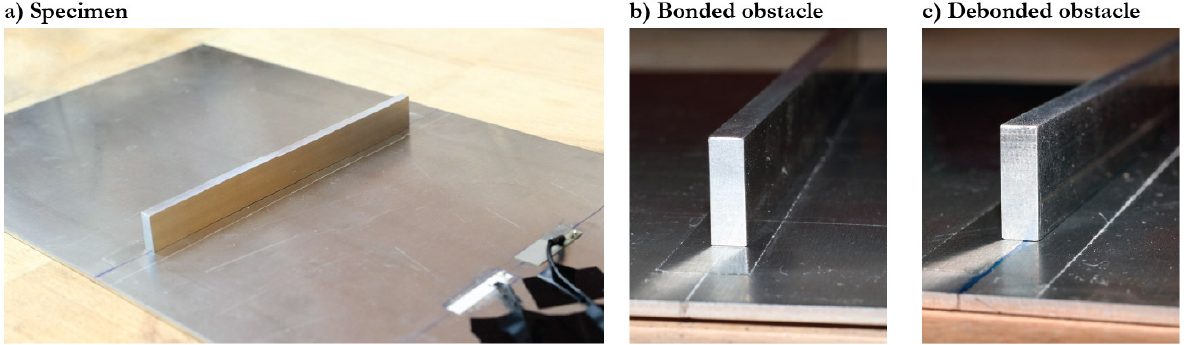
Figure 2. The photography of the